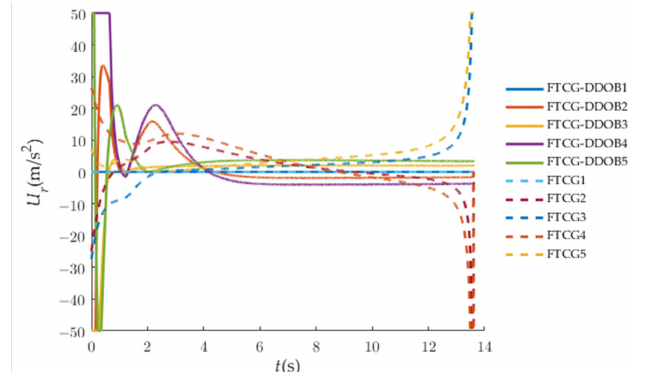
Figure 12. Control-command comparison in LOS direction.